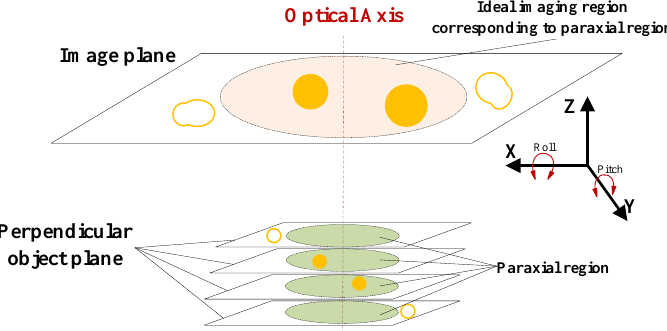
Figure 3. Schematic of the designed dual position-sensitive-detector (PSD)-based unit.